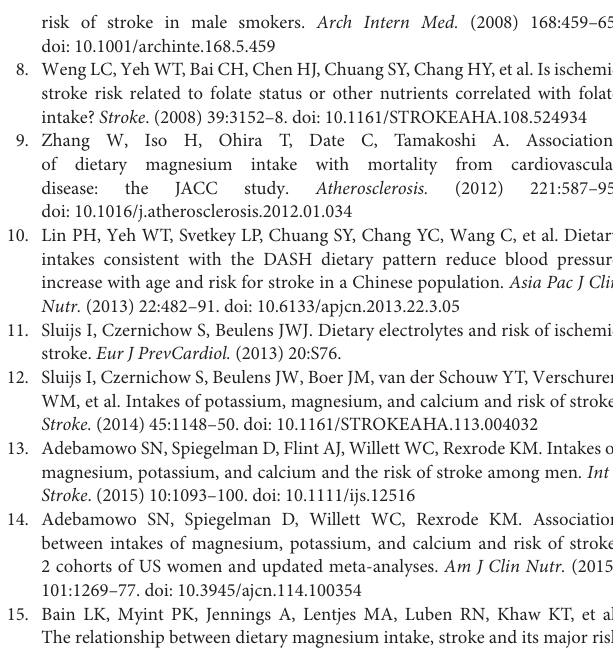
Figure S2 | Trial Sequential Analysis (TSA) of total stroke with the included studies indicated. Figure S3 | Forest Plots of the Risk of Ischemic Stroke for Magnesium Intake (A) and for < 50 mg/day (B) , ≥ 50 and < 100 mg/day (C) , ≥ 100 and < 150 mg/day (D) , and ≥ 150 mg/day magnesium increments (E) . Figure S4 | Trial Sequential Analysis (TSA) for ischemic stroke with included studies indicated. Figure S5 | Forest plots of the risk of hemorrhagic stroke for magnesium intake (A) and for < 50 mg/day (B) , ≥ 50 and < 100 mg/day (C) , ≥ 100 and < 150 mg/day (D) , and ≥ 150 mg/day magnesium increments (E) . Figure S6 | Trial sequential analysis of hemorrhagic stroke comparing the highest magnesium intake category to the lowest. Figure S7 | Trial Sequential Analysis (TSA) for hemorrhagic stroke with the included studies indicated. Figure S8 | Forest plots of the risk of subarachnoid hemorrhage for magnesium intake (A) and for < 50 mg/day (B) , ≥ 50 and < 100 mg/day (C) , ≥ 100 and < 150 mg/day (D) and ≥ 150 mg/day magnesium ranges (E) . Figure S9 | Trial Sequential Analysis (TSA) of subarachnoid hemorrhage (A) , and the TSA of subarachnoid hemorrhage with the included studies indicated (B) . Figure S10 | Forest plots of the risk of intracerebral hemorrhage for magnesium intake (A) and for < 50 mg/day (B) , ≥ 50 and < 100 mg/day (C) , ≥ 100 and < 150 mg/day (D) , and ≥ 150 mg/day magnesium ranges (E) . Figure S11 | Trial Sequential Analysis (TSA) of intracerebral hemorrhage (A) , and the TSA of intracerebral hemorrhage with the included studies indicated (B) . Figure S12 | Two-stage dose-response effects on the relationships between magnesium intake and subarachnoid hemorrhage (A) and intracerebral hemorrhage (B) . Table S1 | PRISMA 2009 checklist. Table S2 | Characteristics of included eligible studies. Table S3 | Methodological quality assessments of the studies included with the newcastle-ottawa